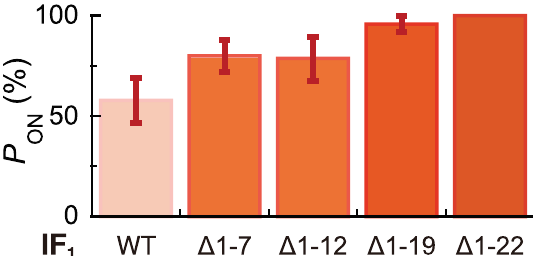
Fig. 5 | Analysis of mutant IF 1 ’ s with the N-terminal truncation. a Enlarged illustration of the interactions between IF 1 and γ subunit in the b MF 1 -IF 1 complex (PDB: 2v7q). S11 and F22 in IF 1 (green) can interact with N15 and I16 in γ subunit (blue),respectively. b Detailsof theIF 1 structure(PDB:2v7q),whereresidues8 – 50 areresolved.Residues1 – 7arenotresolved.Residues8-13areresolvedandforman extended structure. Residues 14 – 18 and 21 – 50 form short and long helix, respec- tively, linked by glycine loop in residues 19 – 20. c Sequence of bovine IF 1 1 – 60 and de fi nition of N-terminal truncated mutants. d , e Reactivation probability of